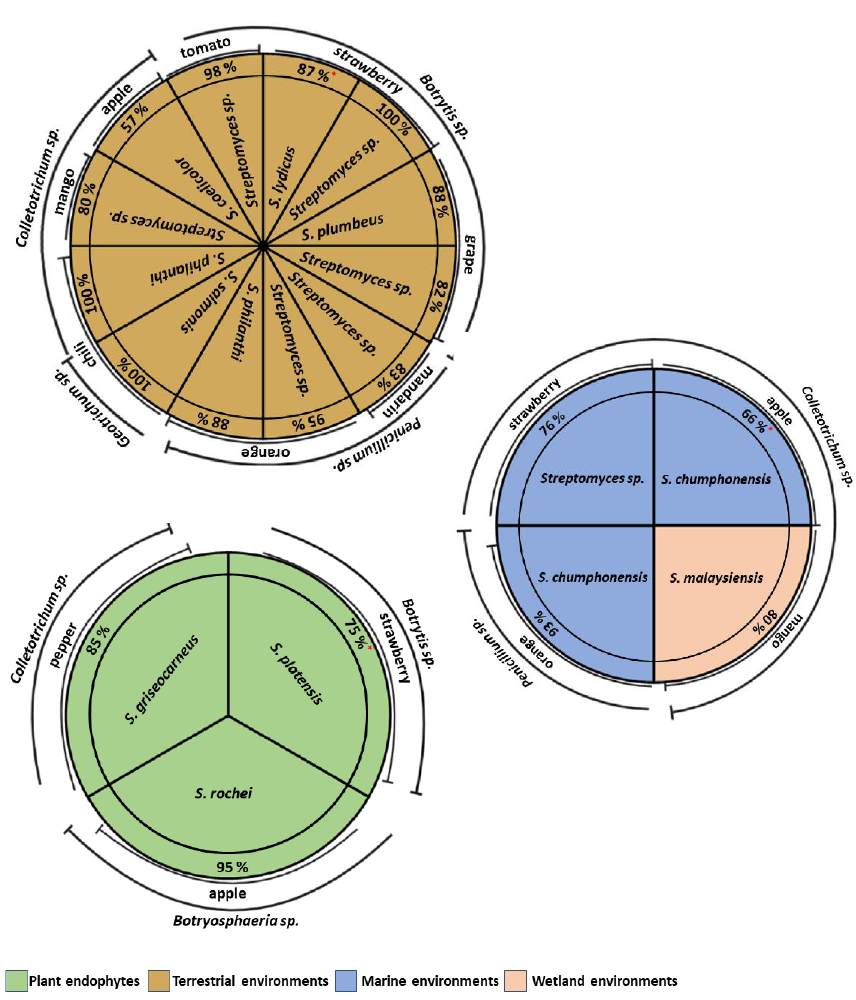
Figure 4. Antifungal activity (% growth inhibition * ) of actinomycetes in post-harvest isolated from different environments [3,19,20,53,64,68,84,102 – 109].